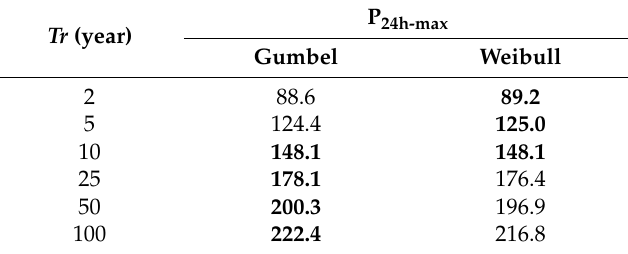
Table 4. P 24h-max values for stationary freq.